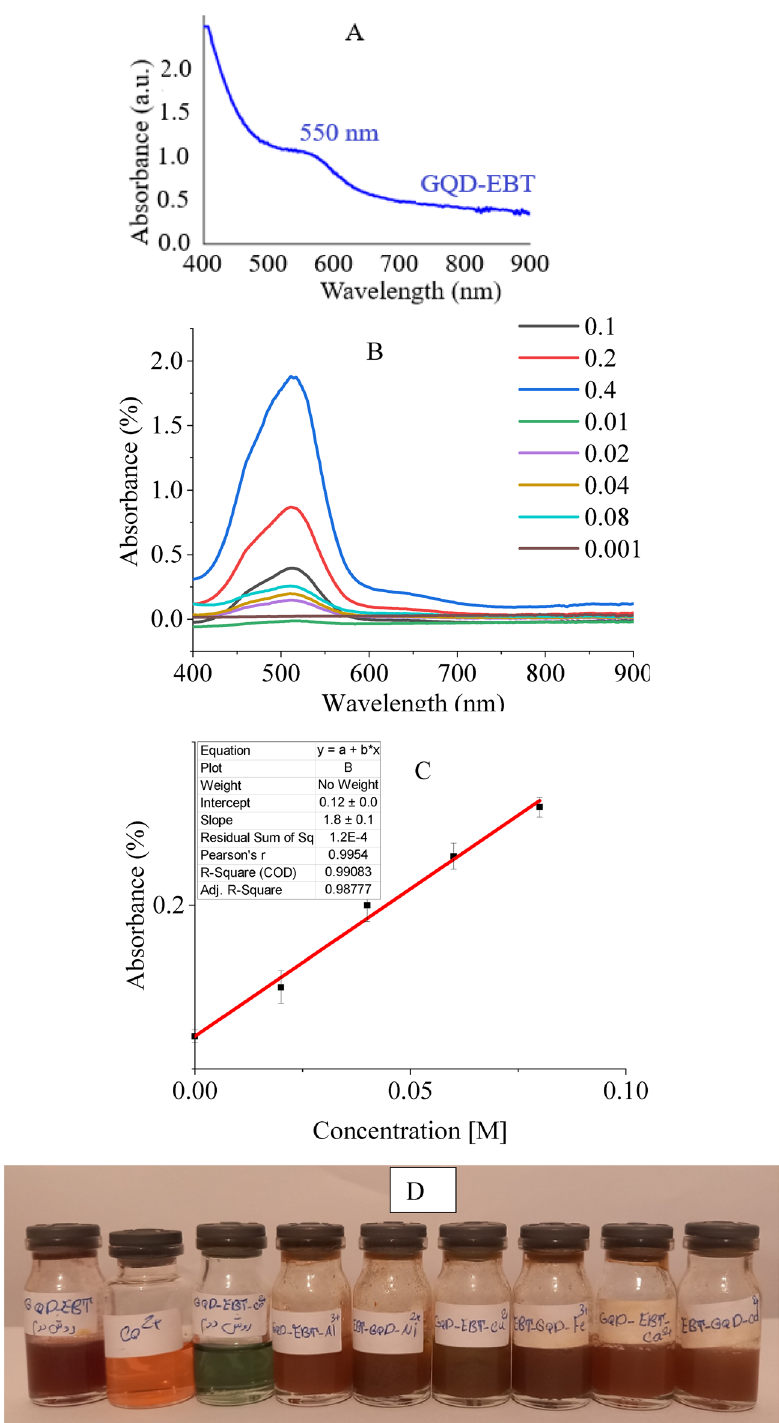
Figure 6. UV–Vis spectrum of GQD-EBT ( A ) and GQD-EBT-Co 2+ in various concentrations of Co 2+ at natural pH ( B ), a linear range of absorbance in various concentrations ( C ), and colorimetric detection of Co 2+ ( D